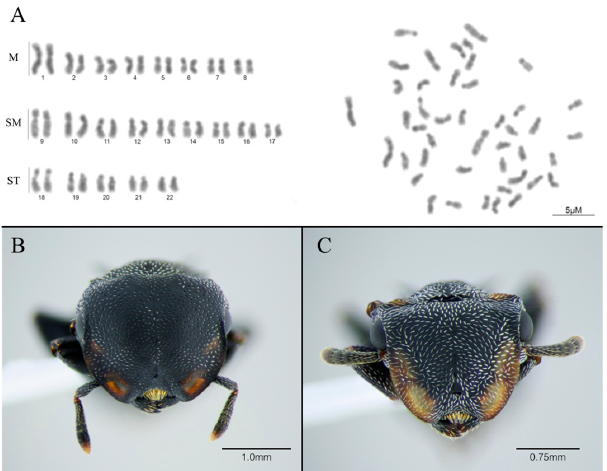
Figure 1. Conventional staining of the complete chromosome set of Cephalotes pusillus . Karyotype and metaphase of female workers of C. pussilus 2n = 44 sorted according to centromeric index ( A ). Automontage front-view pictures of C. pussilus soldier ( B ) and worker ( C ). Table 1. Karymorphometrical analyses of Cephalotes pusilus (Klug, 1824). TL: total length; L: long arm length; S: short arm length; RL: relative length; r : arm ratio (= L/S).